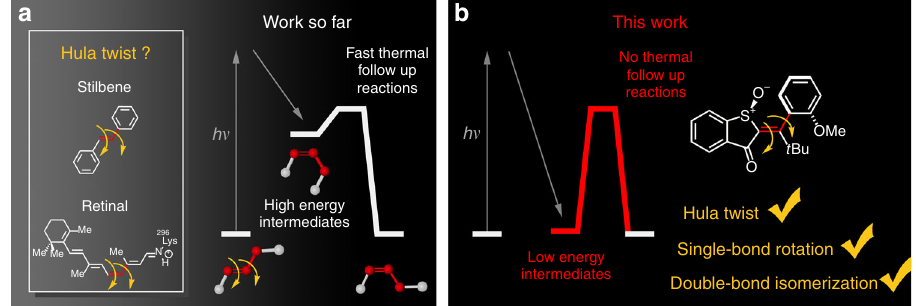
Fig. 1 Complex light-induced motions in chromophores. a Proposed hula-twist (HT) motion for the photoisomerization of stilbene dyes or retinal in rhodopsin. Population of high-energy intermediates after the photoreaction leads to fast thermal decay and hampers a precise elucidation of their structural and electronic properties. b Chromophore 1 possesses only four possible, thermally highly stable, and geometrically distinct intermediate states and therefore enables unambiguous assignment of the photoproducts at ambient conditions. Three different geometrical changes could directly be observed as photoreactions: hula twist (HT), single-bond rotation (SBR), and double-bond isomerization